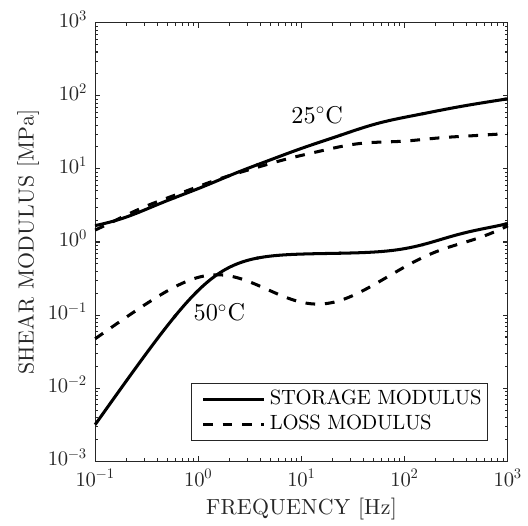
Figure 1. The frequency dependence of the real and imaginary part of the complex shear modulus for polyvinyl butyral (PVB) according to